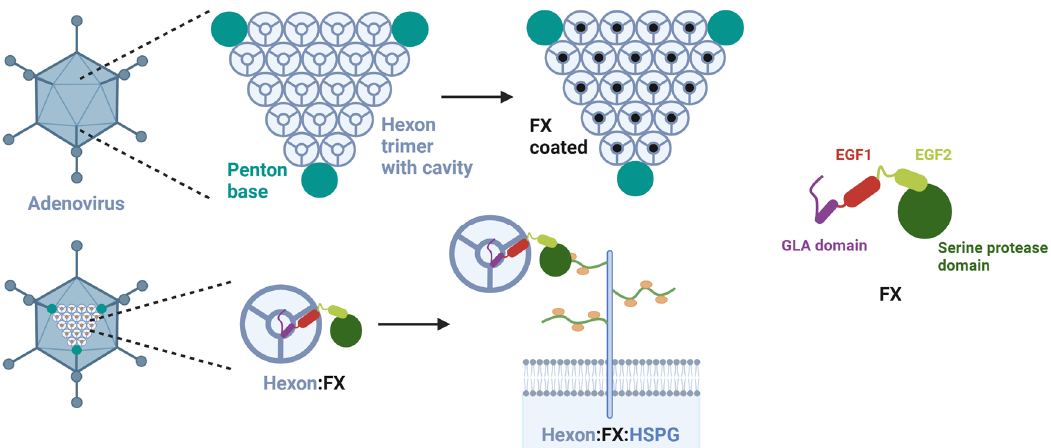
Figure 1. Bridging of adenovirus capsid to HSPG on host cells by FX. The 20 faces of the Ad capsid comprise 240 hexon trimers (gray). In the trimer cavity, the FX binds with its Gla domain (purple) resulting in a protruding serine protease domain (dark green). This serine protease domain bridges the Ad capsid to HSPGs on the host cells, which leads to the uptake of the Ad into the cell [19]. Figure created with Biorender.com.